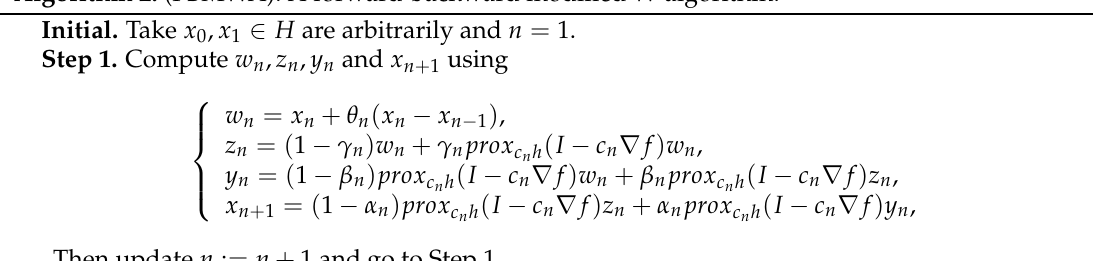
Algorithm 2: (FBMWA): A forward-backward modified